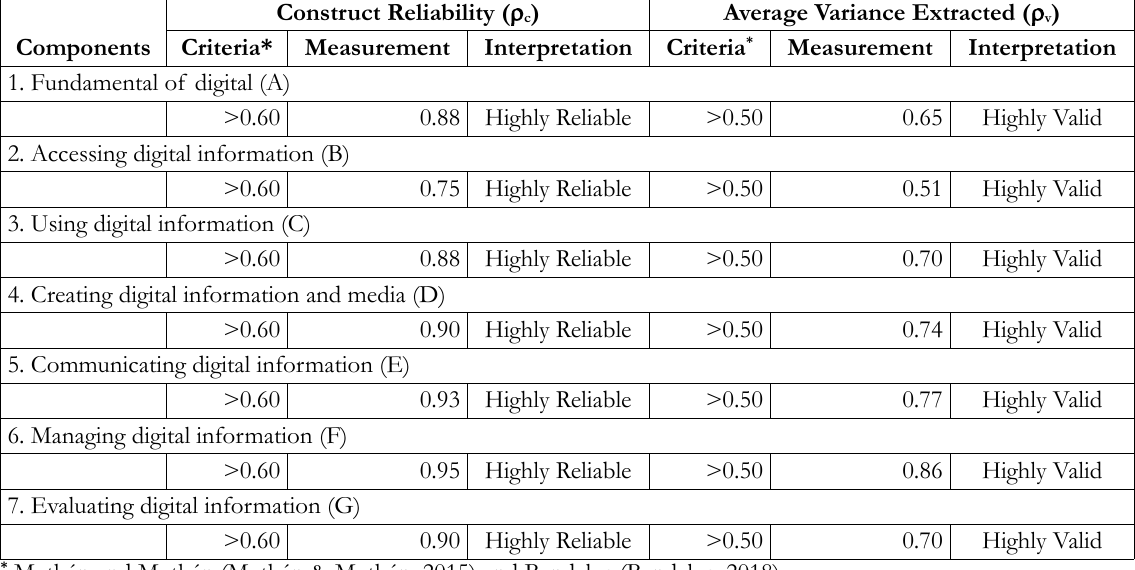
Table 5. Construct reliability and average variance extracted values of the essential digital